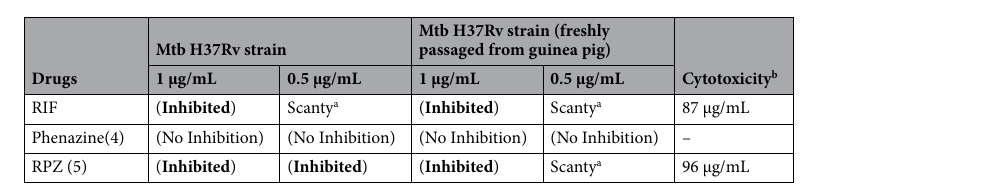
Table 1. Minimum inhibitory concentration (MIC) of drugs and the results of cytotoxicity studies. a Able to see the growth of very few countable colonies. b (IC 50 on human monocytic cell line THP-1).